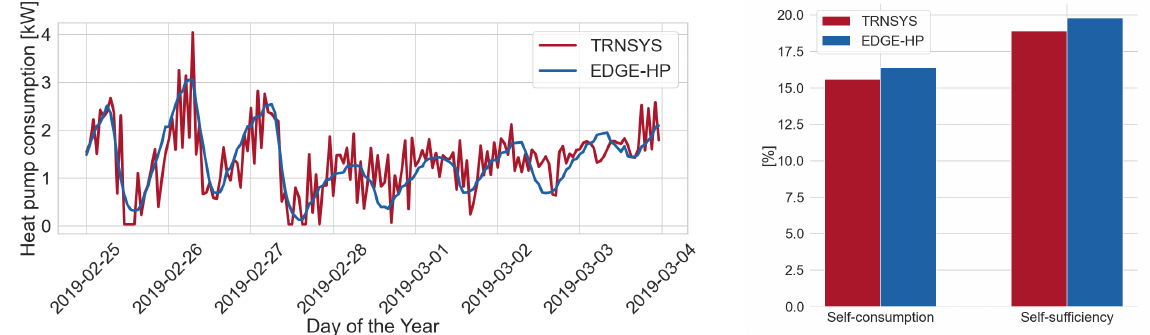
Figure 5. Comparison between TRNSYS and